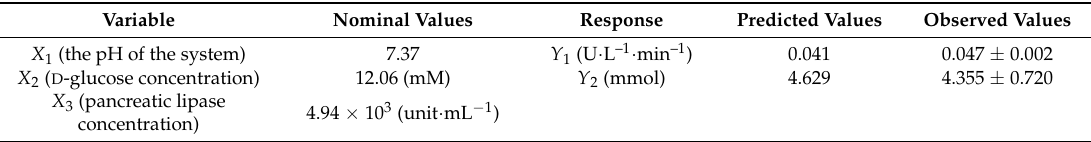
Table 3. Optimized values obtained by the constraints applied on the attenuation rate of